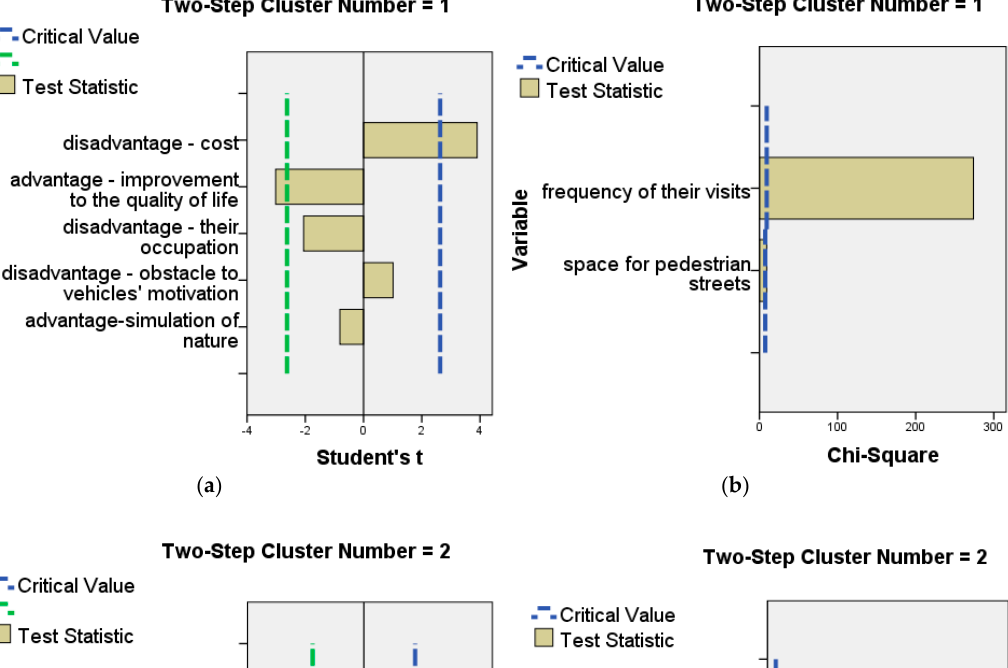
Table 4. Interpretation of the clusters’ observations. Variables